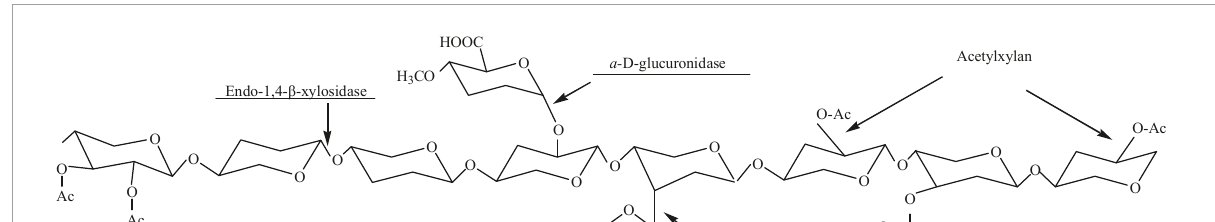
FIGURE5 The effect of xylanase coupled with other enzymes for hemicellulose to produce XOS.